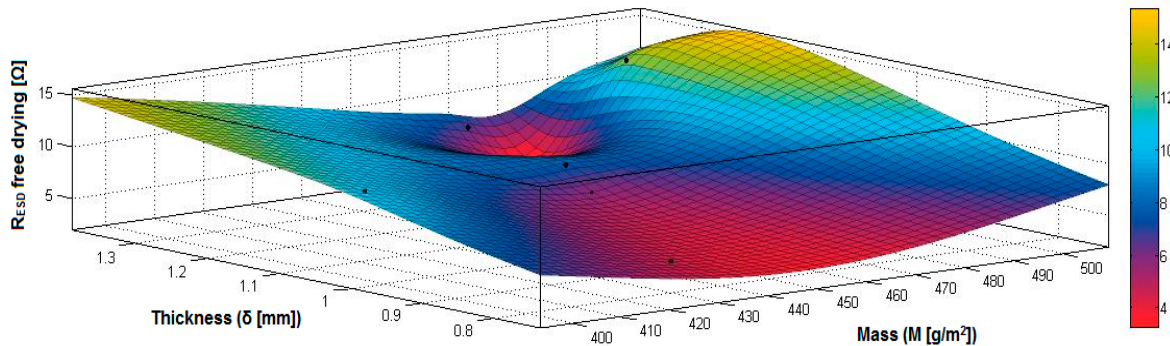
Figure 20. 3D representation R ESD free drying = f(M, δ ) samples preliminarily treated in RF plasma O 2 using RF 1 generator and power 200 W.